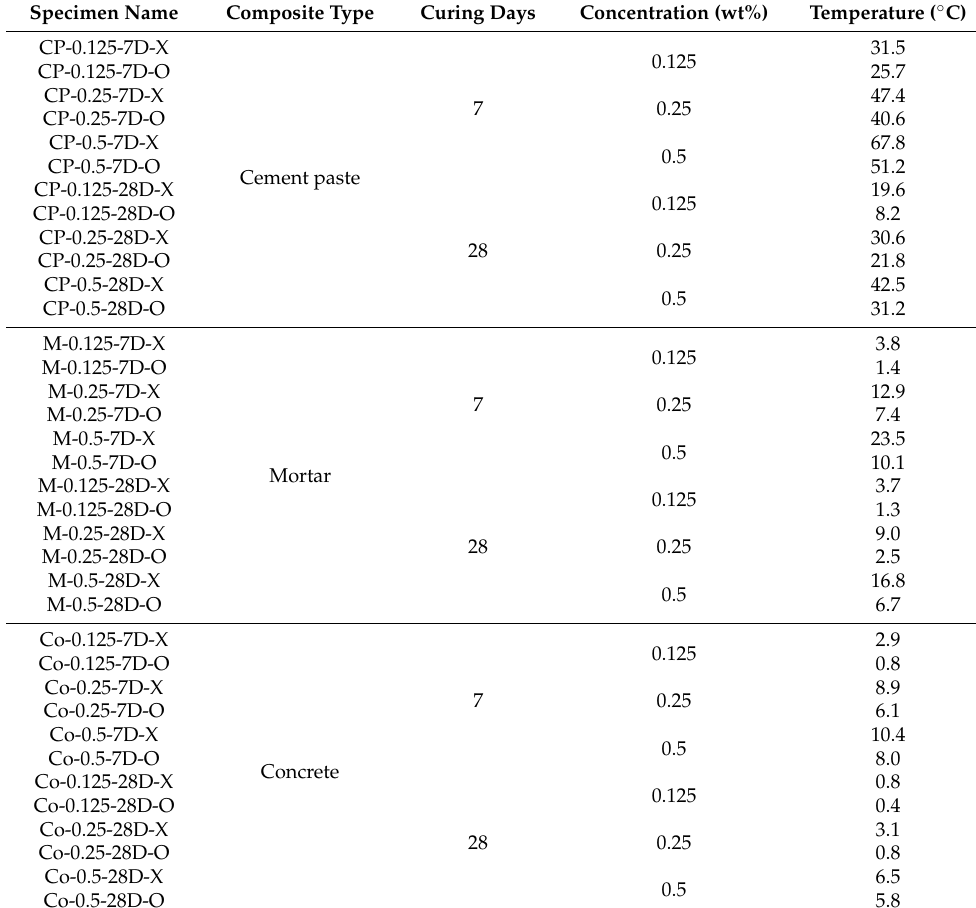
Table 3. Heating test results based on voltage